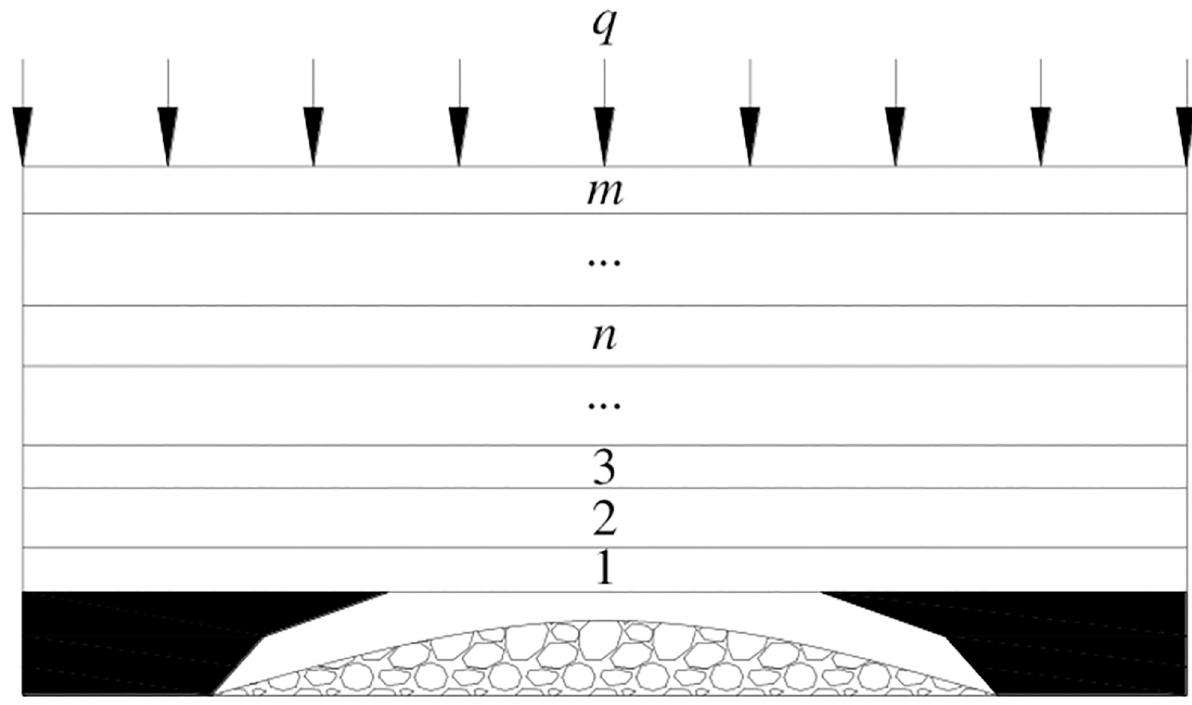
Fig 3. Simplified diagram of the given load of overburden